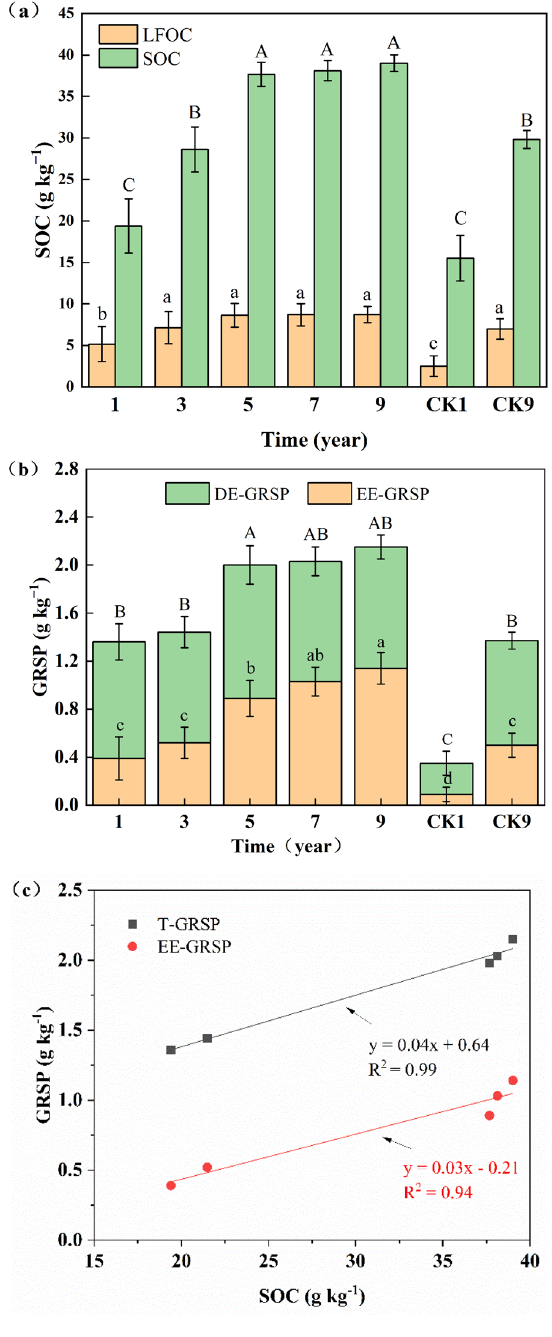
Figure 2. The influence of sludge on ( a ) soil organic carbon (SOC), ( b ) glomalin-related soil protein (GRSP) during the 10-year reclamation period, and ( c ) the relationship between SOC and GRSP under sludge addition. Bars with different letters (lower case for light-fraction SOC (LFOC) and easily extractable GRSP (EE-GRSP), upper case for SOC and difficultly extractable GRSP (DE-GRSP)) indicate a significant difference at the p < 0.05 level. (Total GRSP (T-GRSP) = EE-GRSP +